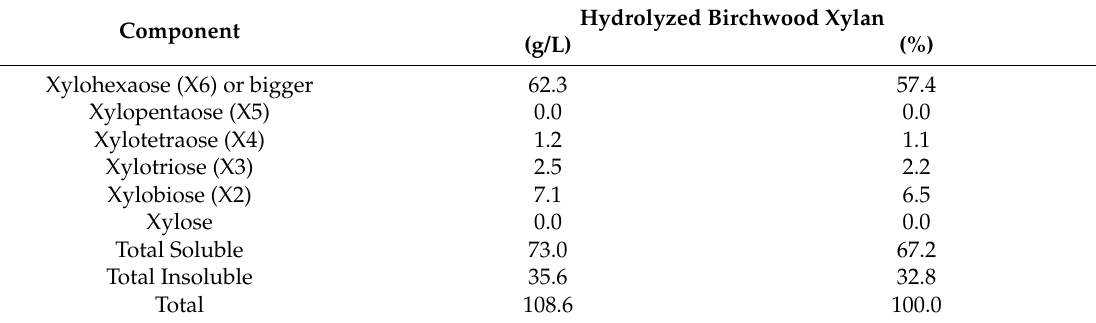
Table 1. Characterization of SHIF substrate: birchwood xylan, 108 g/L after 24 h hydrolysis by